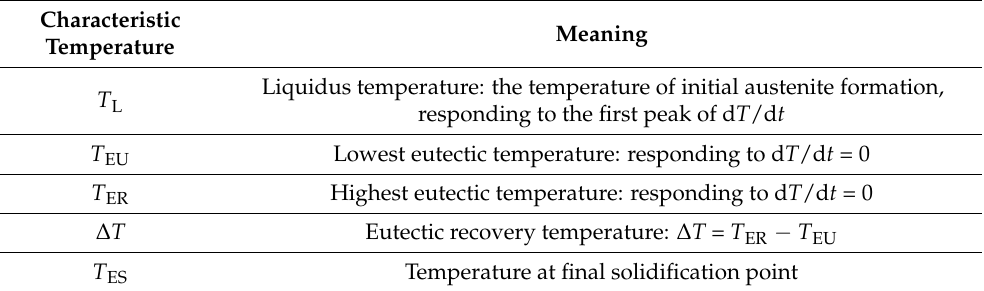
Figure 2. Typical cooling curve ( T - t ), differential curves (d T -d t ) and characteristic temperatures of vermicular graphite iron. Table 3. Meaning of each thermal analysis characteristic